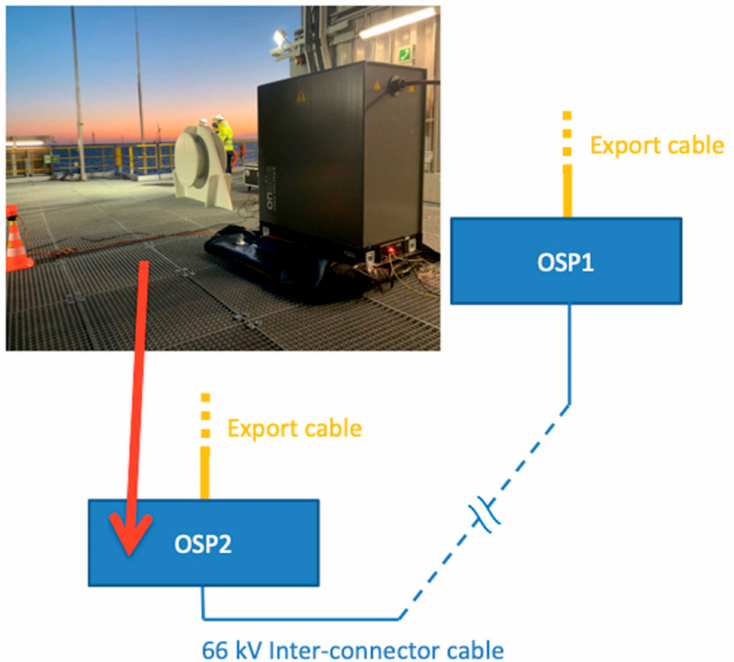
Figure 10. Onsite testing of a 66 kV 10.8 km long XLPE inter-array connector cable system. The HV system is connected to one of the cable section phases. DAC voltages and PD patterns as observed during DAC-monitored voltage withstand